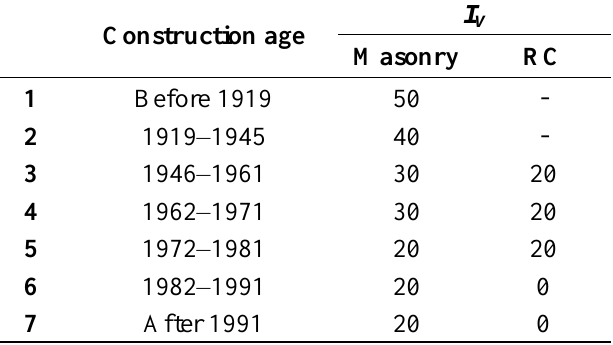
Table 1. Vulnerability indices for building typologies and construction age for the study area (Campania, Southern